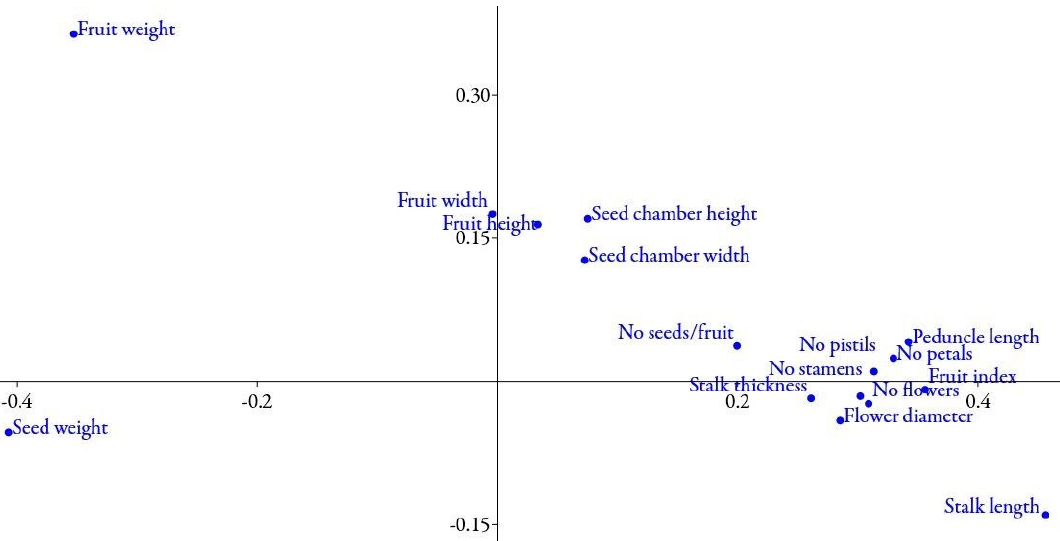
Figure 7. Multivariate analysis performed using correspondence analysis (CA) for the analysed physico- morphological traits, based on 15 ornamental crabapple cultivars